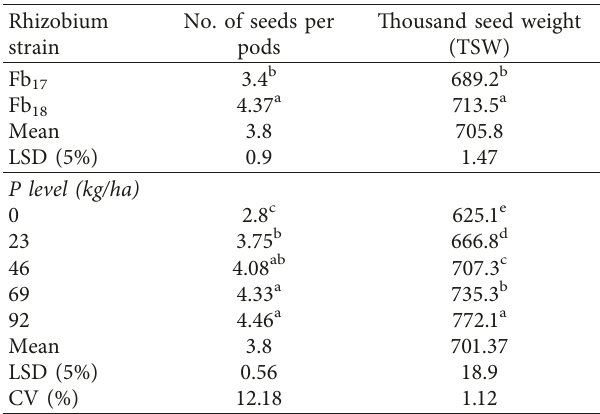
Table 12: The main effects of RI and P fertilizer rates on number of seeds per pods and thousand seed weight.